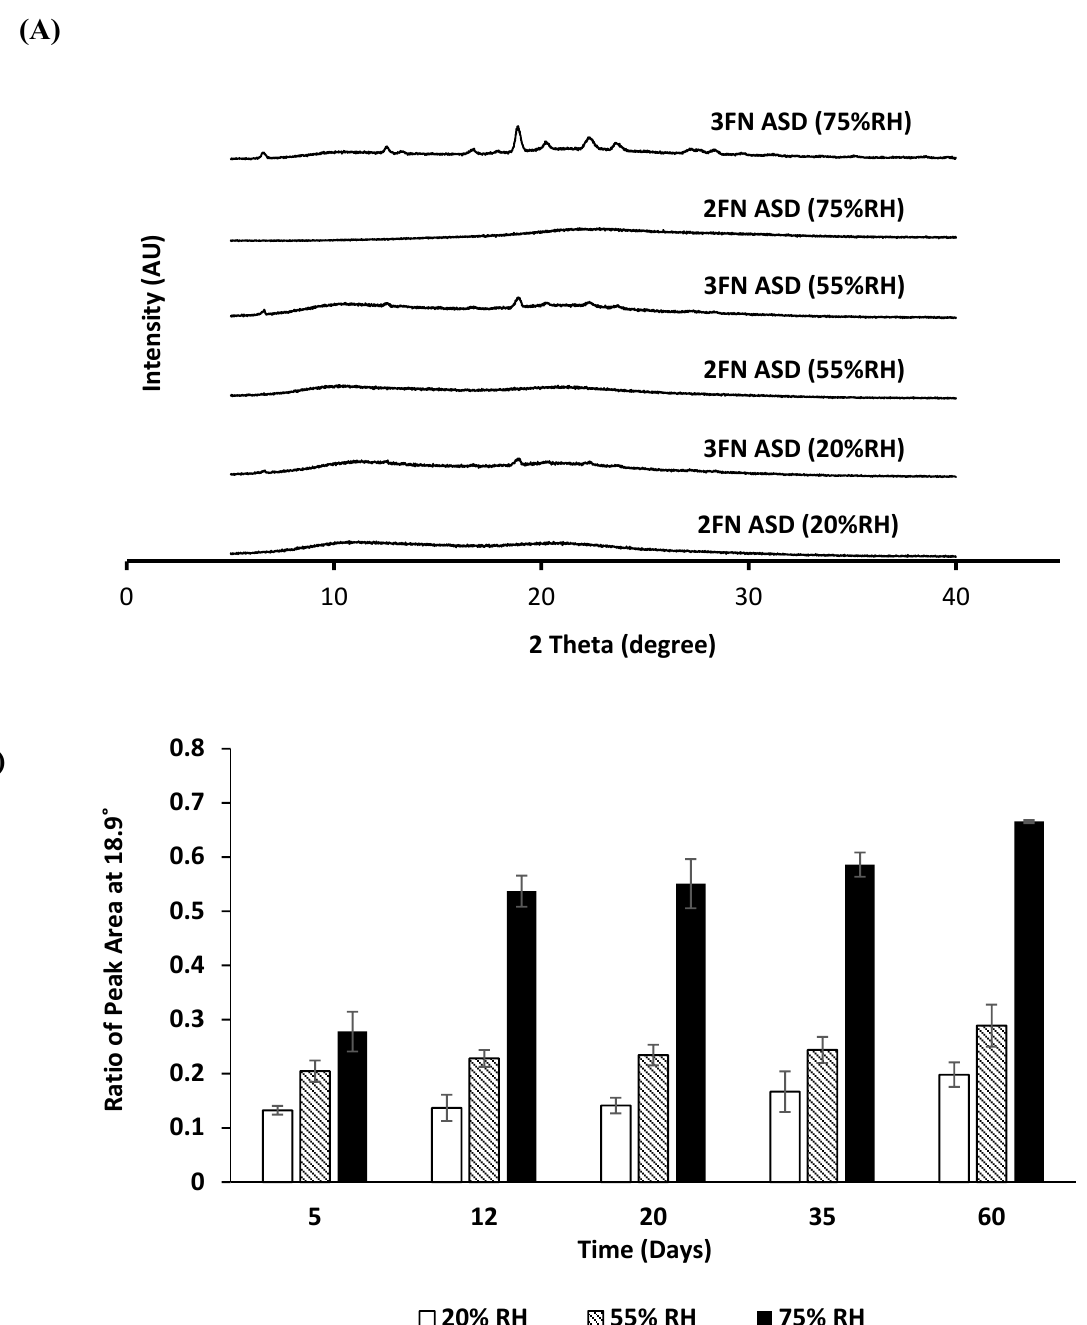
Figure 5. ( A ) X-ray diffraction patterns of naproxen-PVP dispersions (2FN and 3FN) after 60 days storage at 20, 55, and 75% RH; ( B ) the ratio of area under the PXRD pattern for the 3FN naproxen-PVP dispersion and pure crystalline naproxen at 2 θ = 18.9° (mean ± SD, n = 3).